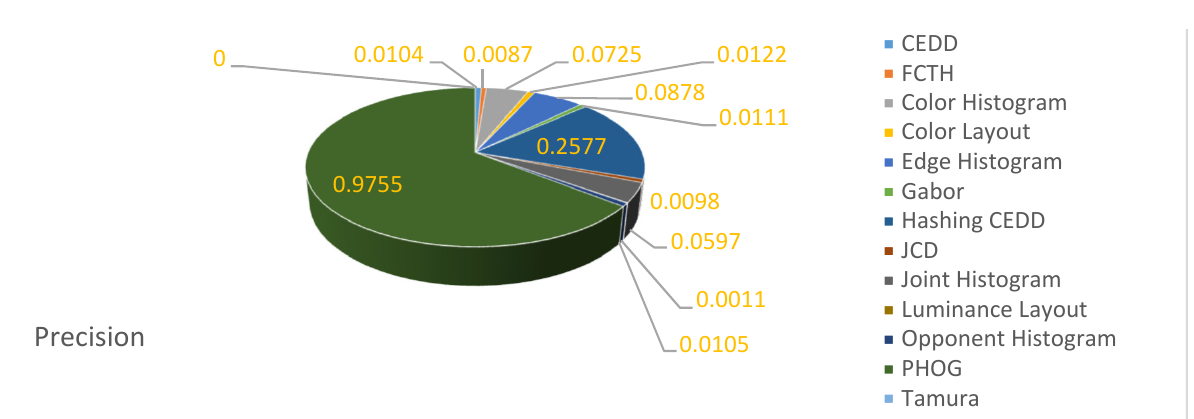
Figure 23. Precision@10000 retrieval quality.